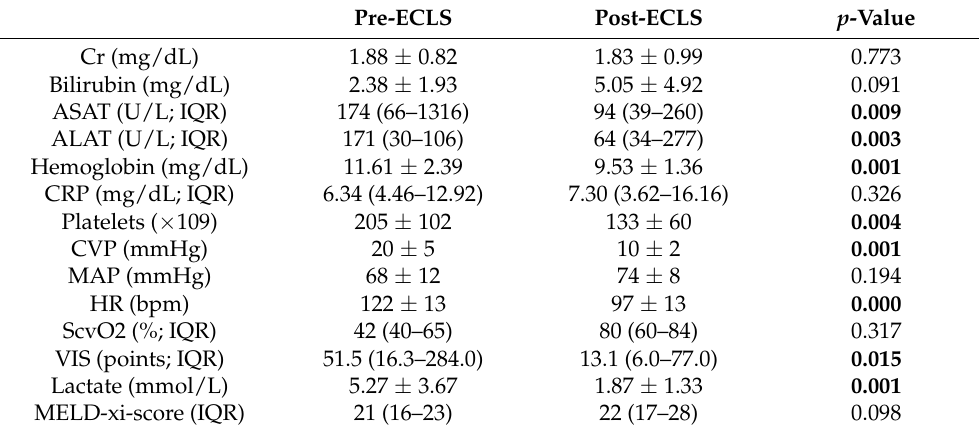
Table 1. Clinical parameters pre and post ECLS ( n =